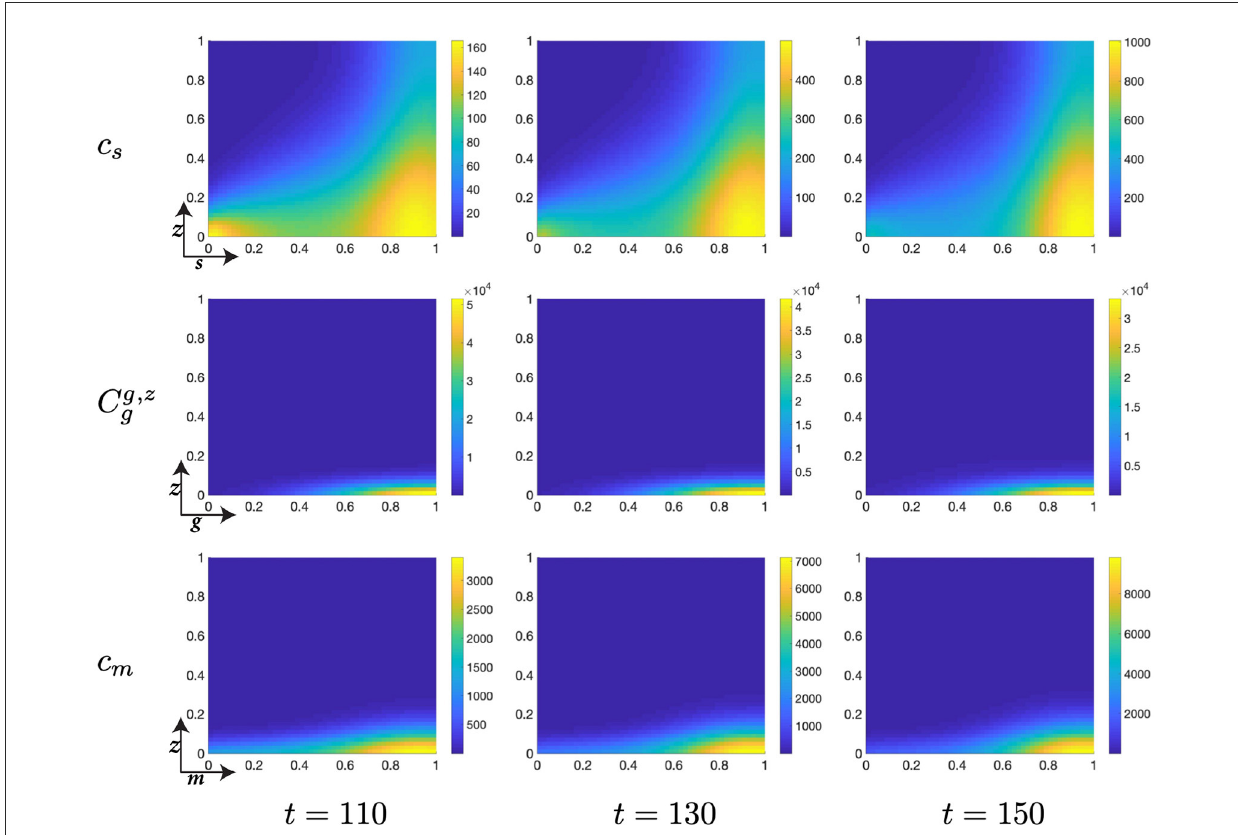
FIGURE8 Structured cell populations with S-cyclins ( s ) and DNA-damage ( z ), given in the S-phase ( c s ); G-cyclins ( g ) and DNA-damage ( z ), given in the G-phase ( C g , z g ); and M-cyclins ( m ) and DNA-damage ( z ), given in the M-phase ( c m ), solved for t